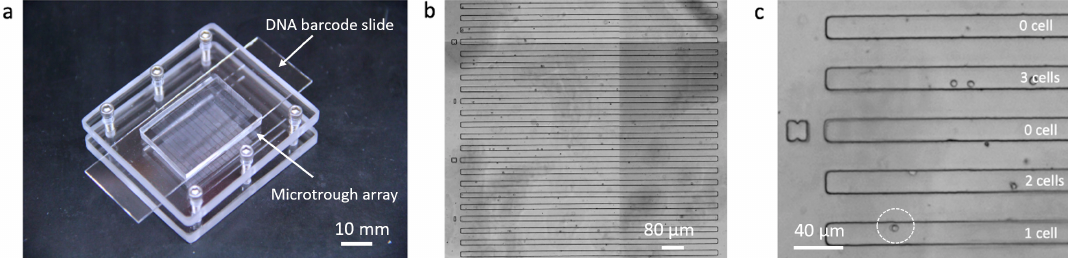
Figure 2. Sub-nanoliter microtrough array chip. ( a ) Fully assembled device; ( b ) microtroughs imaged with a motorized microscope; ( c ) enlarged view of a region of interest showing single or multiple THP-1 cells trapped in individual microtroughs.